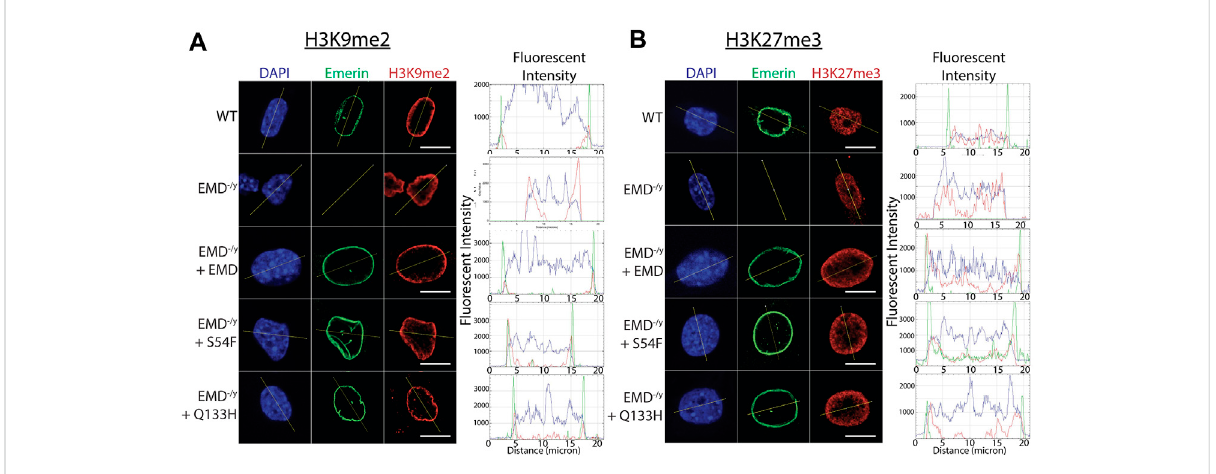
FIGURE 3 ConfocalimagingshowsenrichmentofH3K9me2andH3K27me3atthenuclearperiphery. (A,B) Wildtypemyogenicprogenitorsoremerinnull myogenic progenitors expressing WT emerin, S54F emerin, or Q133H emerin were fi xed and incubated with antibodies against emerin and H3K9me2 (A) or H3K27me3 (B) . Representative images of DAPI, emerin, and H3K9me2 or H3K27me3 staining are shown. Images were analyzed usingImageJsoftware to measure enrichmentatthenuclear envelope. A line wasdrawn acrossthenucleus ineach fi eldand fl uorescence was quanti fi ed along the line. Representative line graphs are shown for each set of images (N > 30 for each cell line). Scale bars represent 10